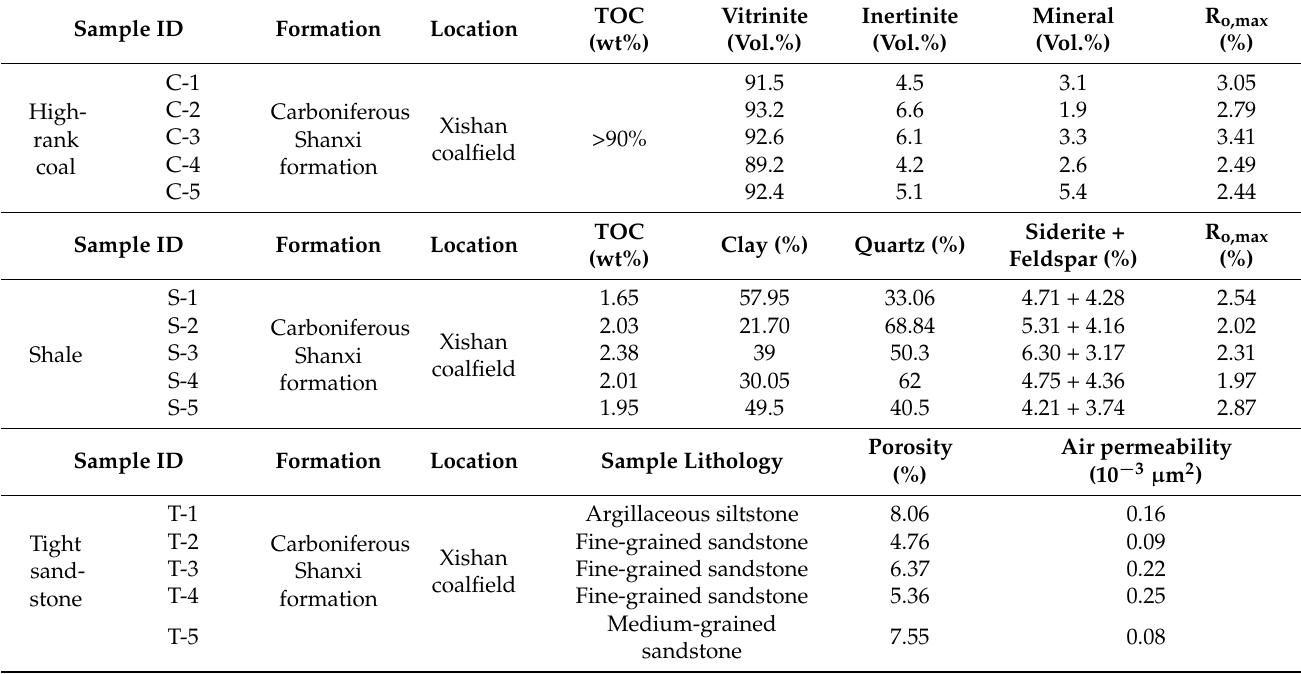
Table 1. Sample properties of high-rank coal, shale and tight sandstone in